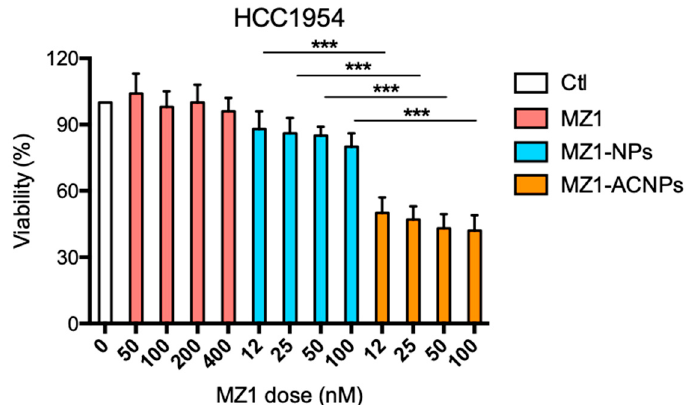
Figure 5. MZ1-ACNPs rendered a strong cytotoxic e ff ect in trastuzumab, MZ1-naturally resistant cell line HCC1954. Cell viability (in %, referred to the DMSO vehicle) by MTT assay under treatment with free MZ1, MZ1-NPs, or MZ1-ACNPs. *** p < 0.001.